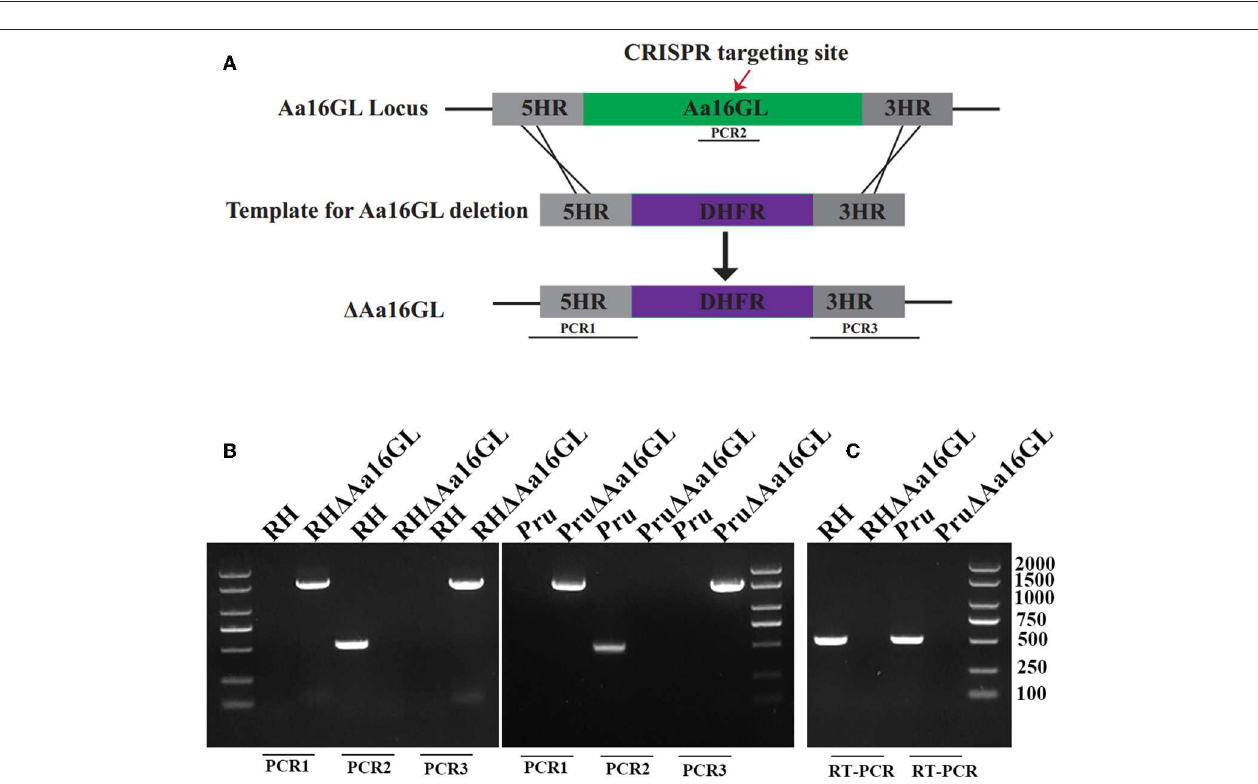
FIGURE 2 | Construction of Toxoplasma gondii amylo-alpha-1,6-glucosidase knockout mutant strain. (A) Schematic model of deleting Aa16GL by CRISPR-Cas9-mediated homologous gene replacement. (B) Diagnostic PCRs show successful knockout of the Aa16GL gene, which was also confirmed at mRNA level by using (C)